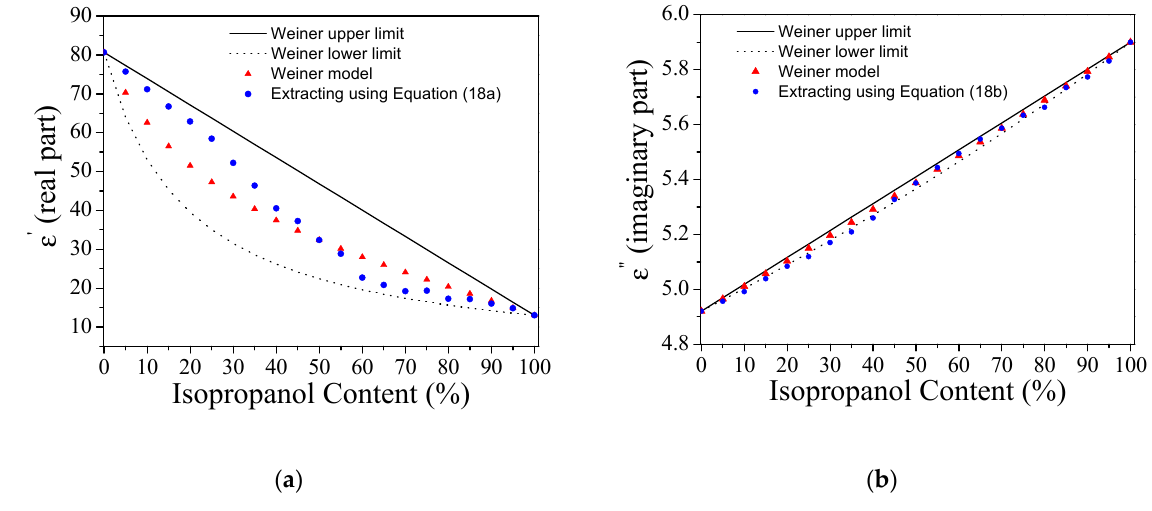
Figure 10. Extracted value for the complex dielectric constant in mixtures of deionized (DI) water / isopropanol. ( a ) Real part. ( b ) Imaginary part. The static Weiner model (upper and lower limits) is also included for comparison purposes.